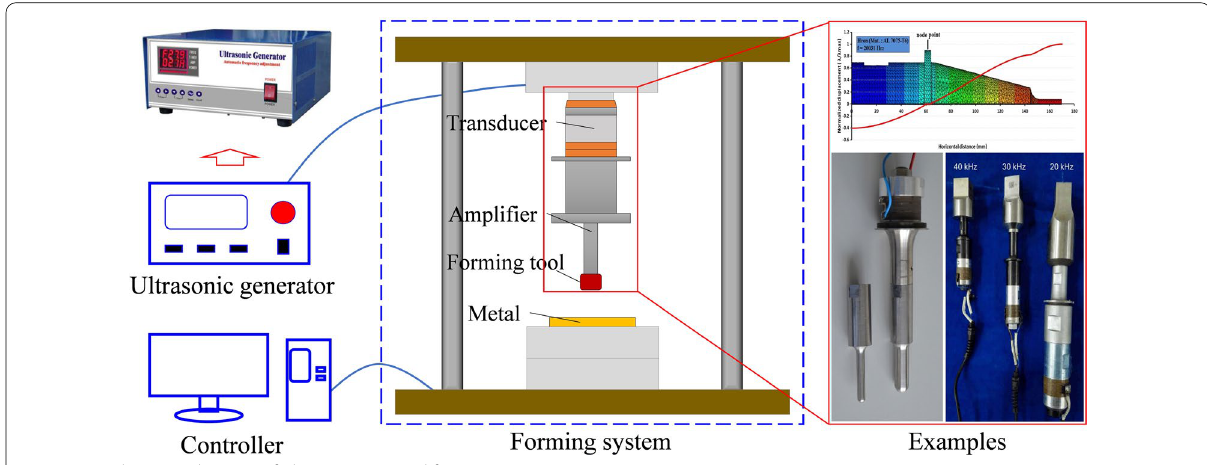
Figure 1 Schematic diagram of ultrasonic-assisted forming system